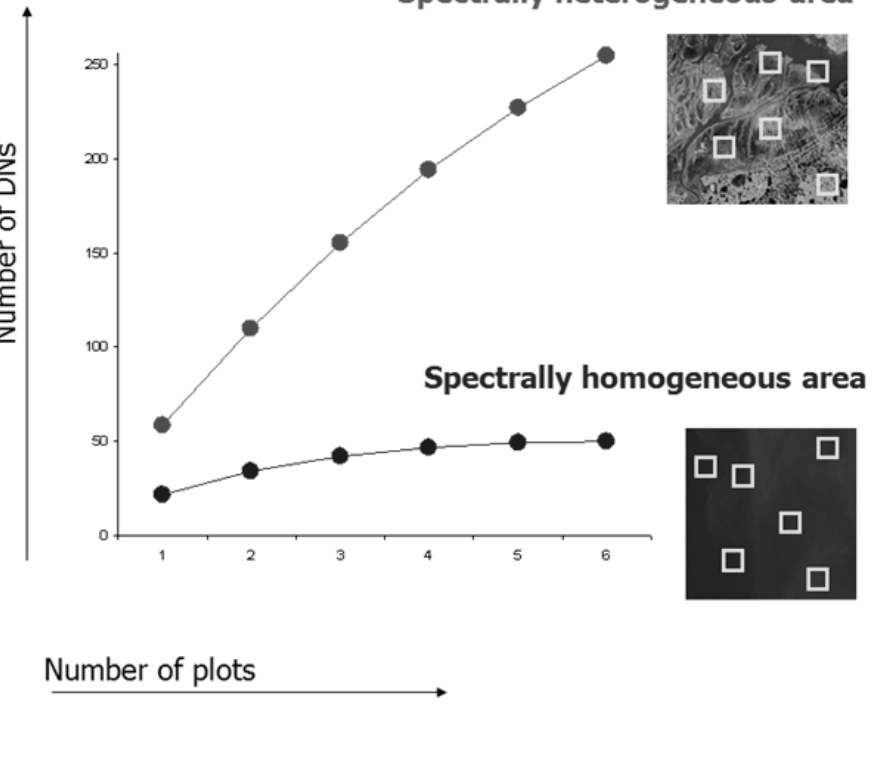
Figure 3. A worked example of spectral rarefaction.. Once differently heterogeneous areas are sampled by the same number of plots (windows) containing the same number of inner pixels, the rarefaction curves computed by Eq.(1) provide an estimate of the number of different DNs at various spatial scales. Obviously only one band or the first PC can be used at once. See the main text for major